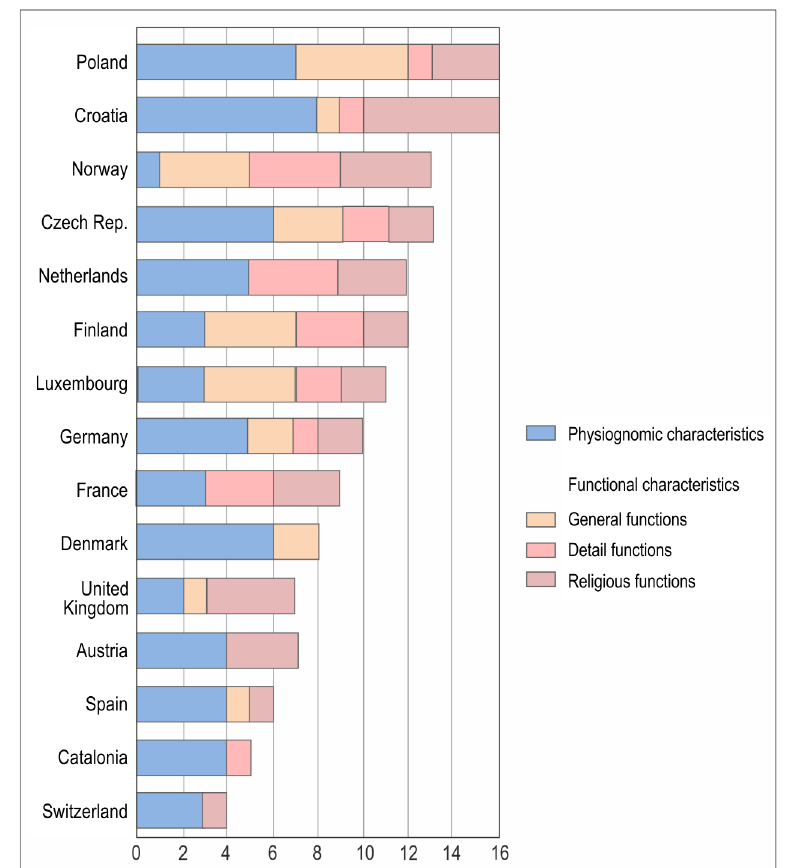
Fig. 2. The number of characteristics of buildings, structures and build-up areas on 1:25,000 maps, divided into different